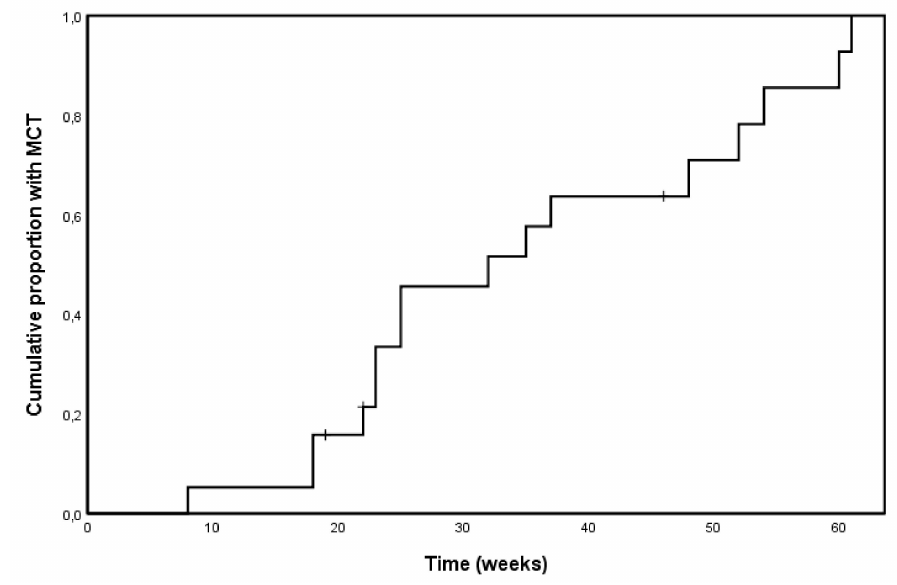
Figure 2. Kaplan-Meier curve of time to the development of mild cardiac toxicity